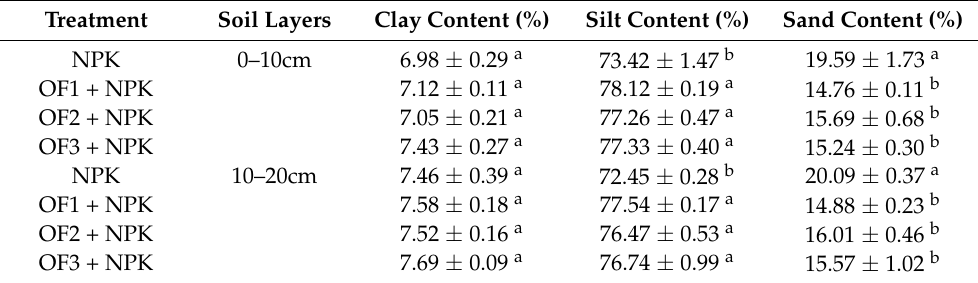
Table 3. Effects of organic–inorganic fertilizers on clay, silt, and sand percentages in a dry direct- seeded paddy soil.